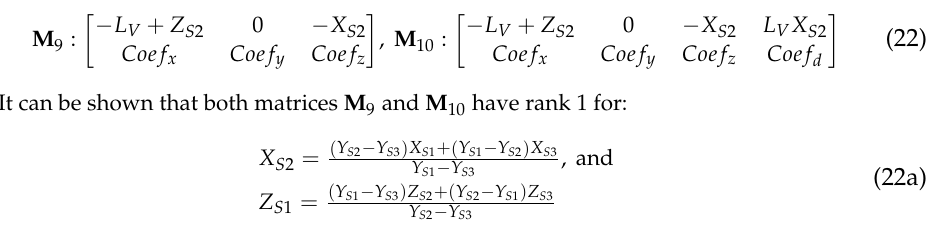
istic tetrahedron are coplanar): ( a ) parallel robot pose; ( b ) characteristic planes. In Case 5, one side and the base of the characteristic tetrahedron are coplanar [30].